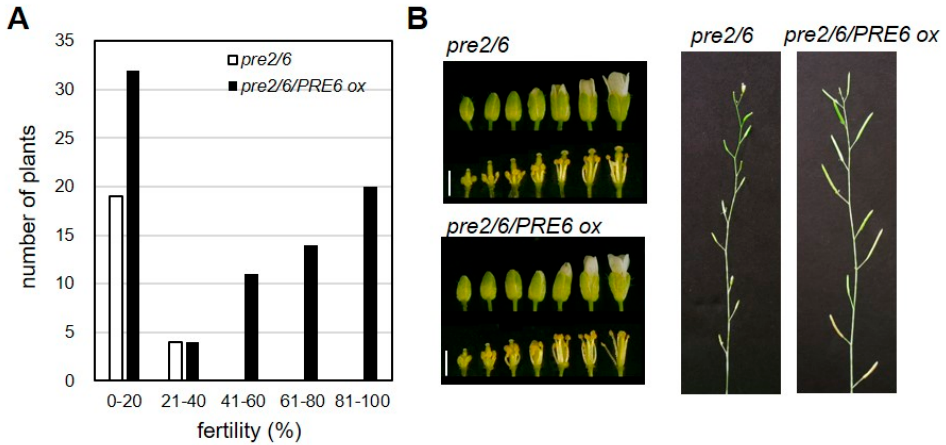
Figure 3. PRE6 overexpression rescued the sterility of pre2pre6 . The pre2pre6 plants were transformed with Agrobacterium carrying the PRE6 overexpressing vector. Full-length cDNA of PRE6 was cloned into the plant overexpression vector. The primary transformants (T1) were selected and subjected to fertility analysis. ( A ) Fertility of T1 plants was scored by percentage of fully mature siliques per total flowers of the primary inflorescence. We analyzed 81 T1 plants of overexpressing PRE6 in pre2pre6 mutant background. ( B ) Left, representative flower morphology at various developmental stages. Scale bar, 1 mm. Right, representative primary inflorescences of pre2pre6 and a transgenic line overexpressing PRE6 .